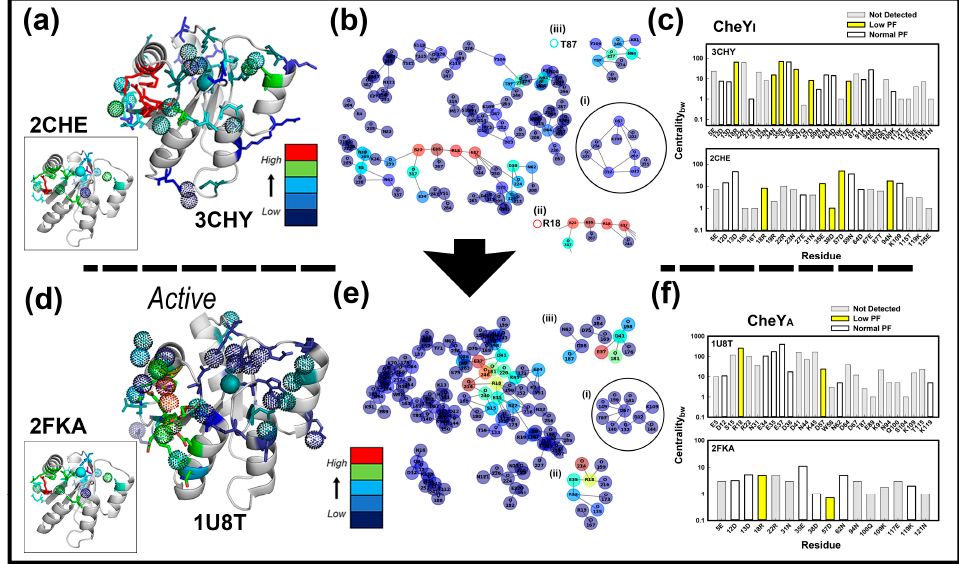
Figure 4. Changes in the Bridge2 CheY hydrogen-bonded protein-water network upon activation. Bars = Color-coded 𝐶 (cid:3029)(cid:3030) values (Blue (Low) -> Red (High)). ( a – c ). Inactive apo-CheY. ( a ) The 𝐶 (cid:3029)(cid:3030) nodes mapped onto the 3D structure. Residues detected by XFMS (stick sidechains). Water (dotted spheres). Mg 2+ (cyan spheres), BeF3 (magenta sticks). ( b ) The 2D map of the network. Local nodes ( i ) 109K -> 57D (circled [19]) ( ii ) 18R. ( iii ) 94N -> 106Y. ( c ) The 𝐶 (cid:3029)(cid:3030) nodes targeted by XFMS detected residues (low (yellow), normal (white)). ( d – f ). Activated CheY13DK106YW in complex with FliMN. ( d ) The 𝐶 (cid:3029)(cid:3030) nodes mapped onto the 3D structure. Residues detected by XFMS and waters (dotted spheres) as in ( a ). ( e ) The 2D map of the network. Local nodes ( i ) 109K -> 57D (circled [19]) ( ii ) 18R. ( iii ) 37E -> 41D, 38D -> 62N, 75D ( f ) The 𝐶 (cid:3029)(cid:3030) nodes targeted by XFMS detected residues (anomalous (yellow), comparable (white)). Bridge2 residue nomenclature, where type precedes position, is different from nomenclature used elsewhere in the text.